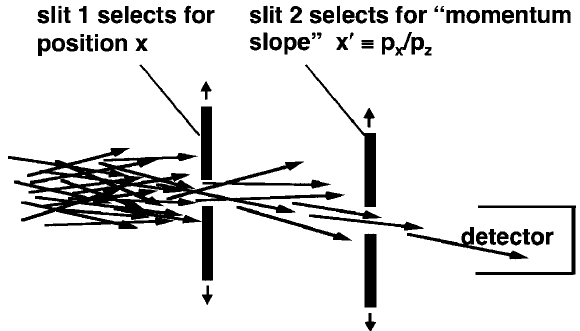
FIG. 5. Sketch of a two-slit technique for mapping the ( x; x 0 ) phase space of a beam.